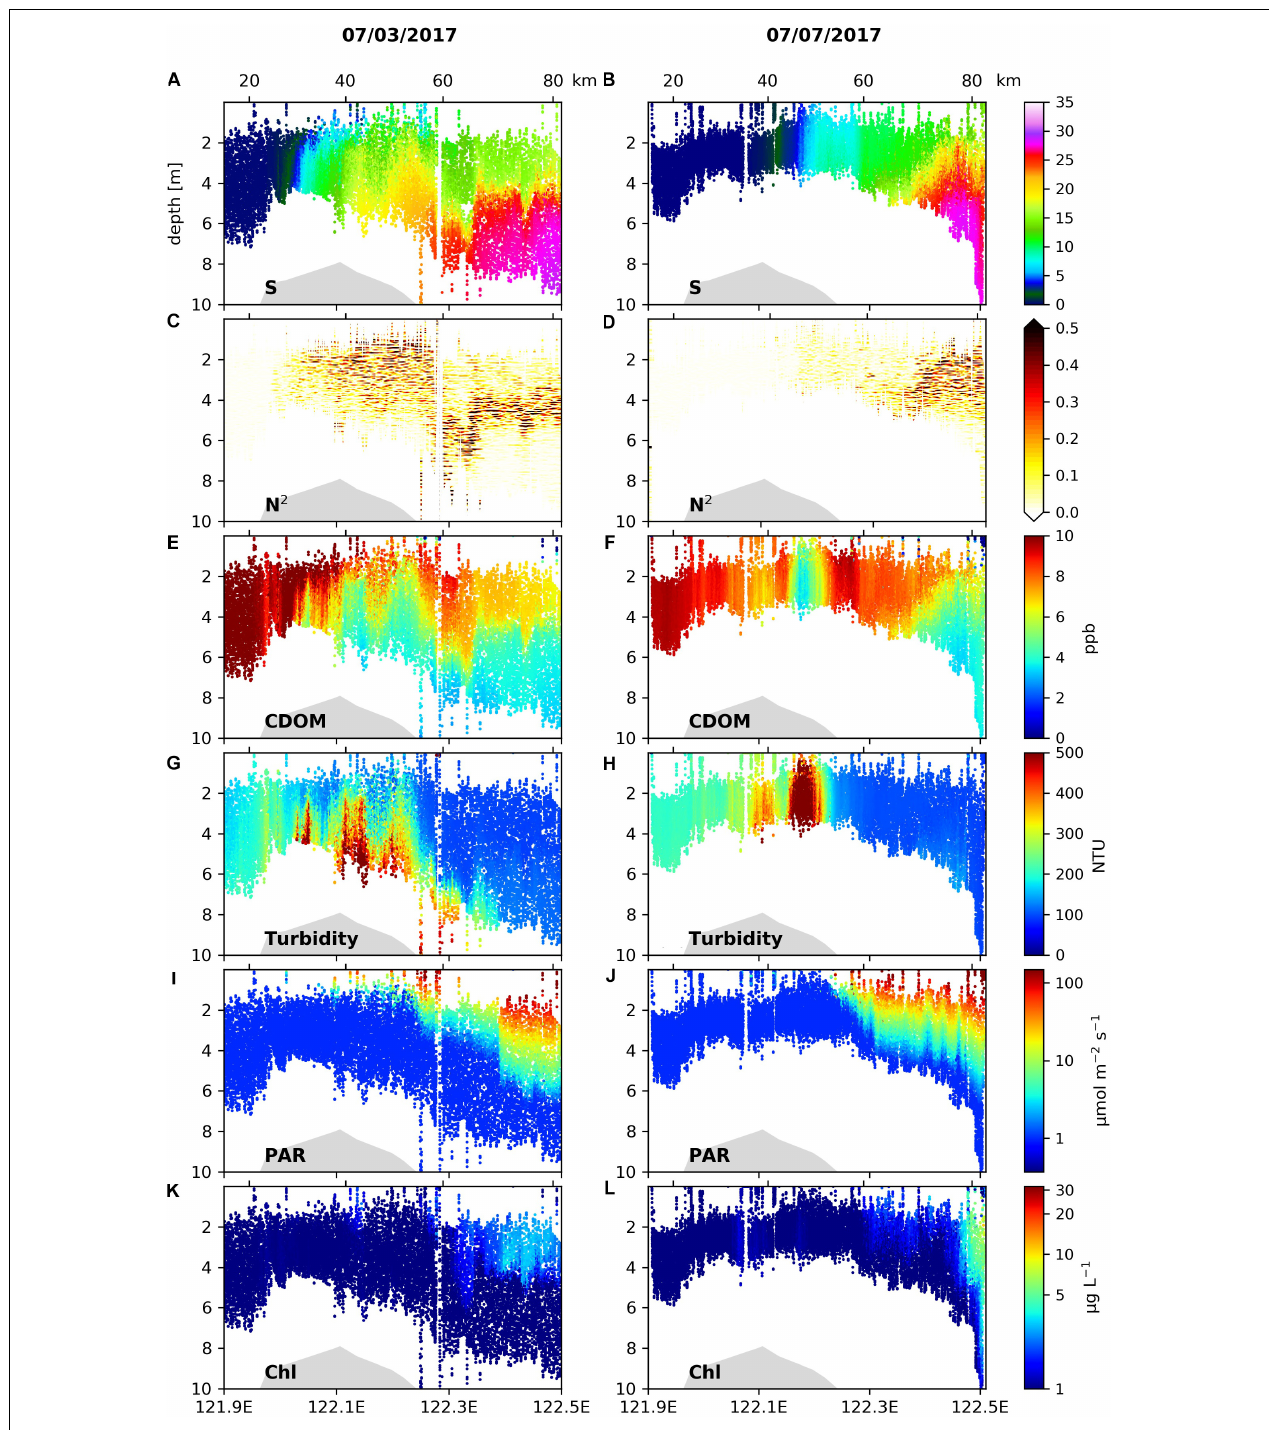
FIGURE 3 | Vertical profiles of (A,B) salinity, (C,D) stratification frequency ( N 2 ), (E,F) CDOM concentrations, (G,H) turbidity, (I,J) PAR and (K,L) Chl concentrations along 121.9–122.5 ◦ E of Transect C1 surveyed on 3 July 2017 (left panels) and 7 July 2017 (right panels).